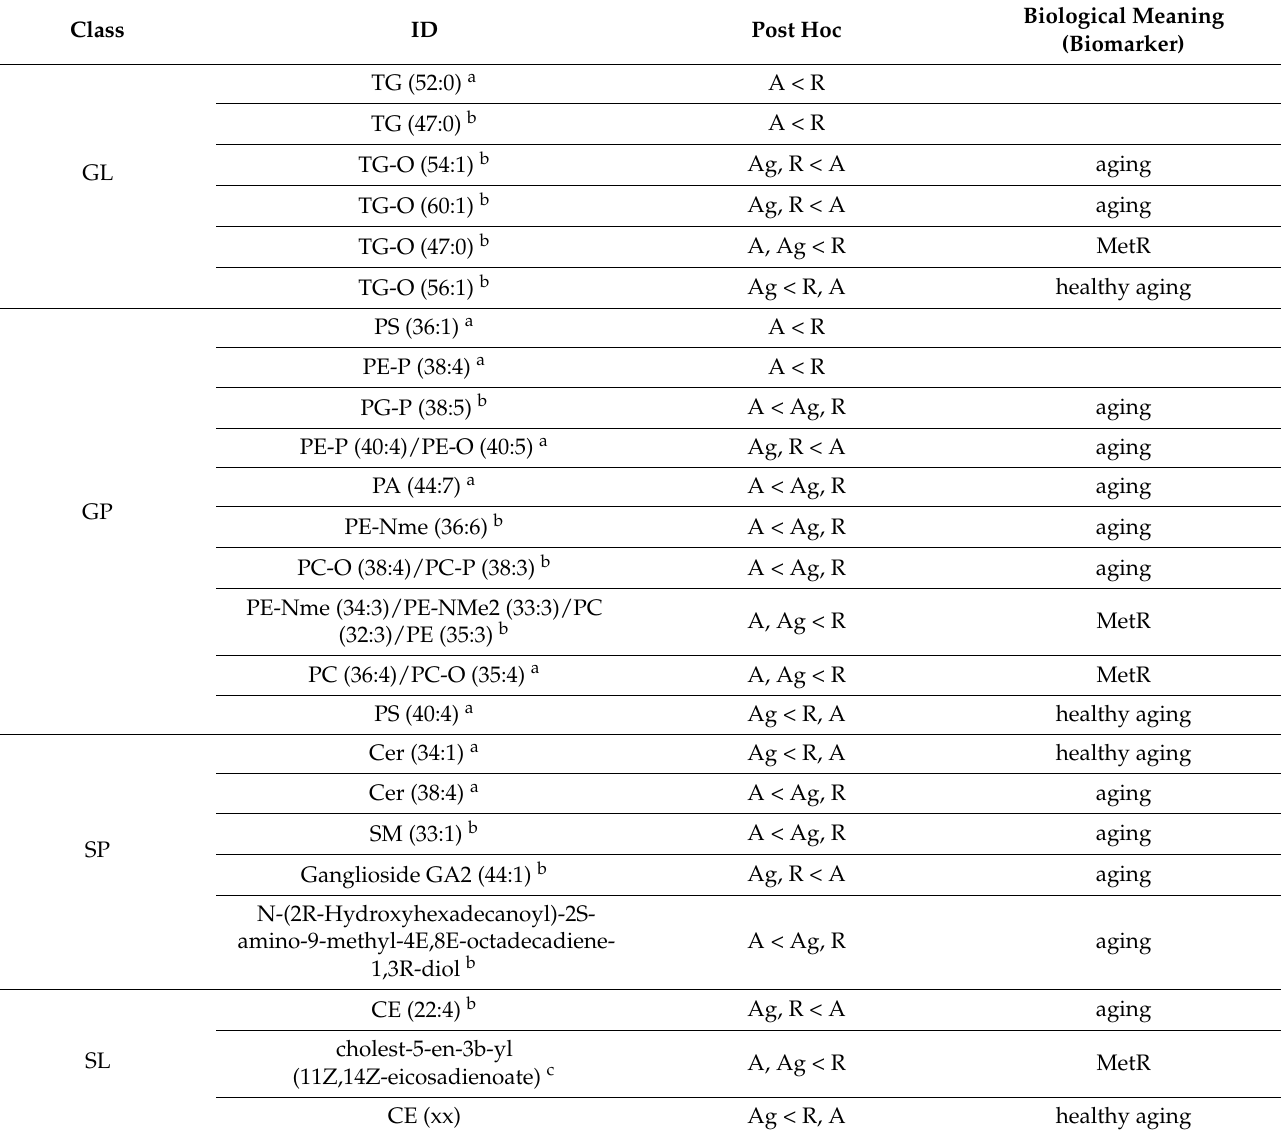
Table 1. Lipid species significantly different between experimental groups in the rat